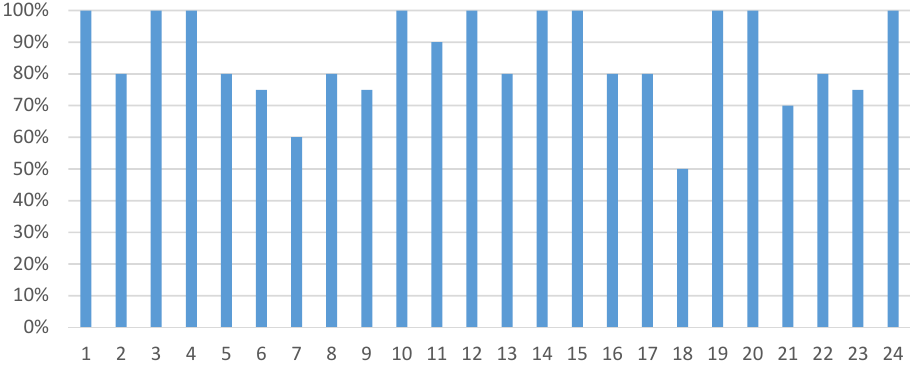
Figure 11. The overlap of display content in each junction nodes selected by two schemes.